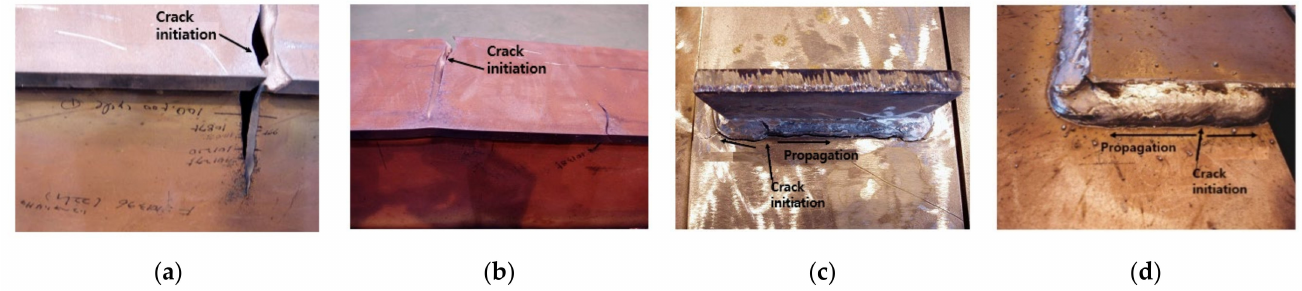
Figure 24. Fatigue crack initiation and propagation of real-size beams. ( a ) box beam, non PWHT; ( b ) box beam, PWHT; ( c ) box beam V with a vertical gusset, non PWHT; ( d ) box beam H with a horizontal gusset, non